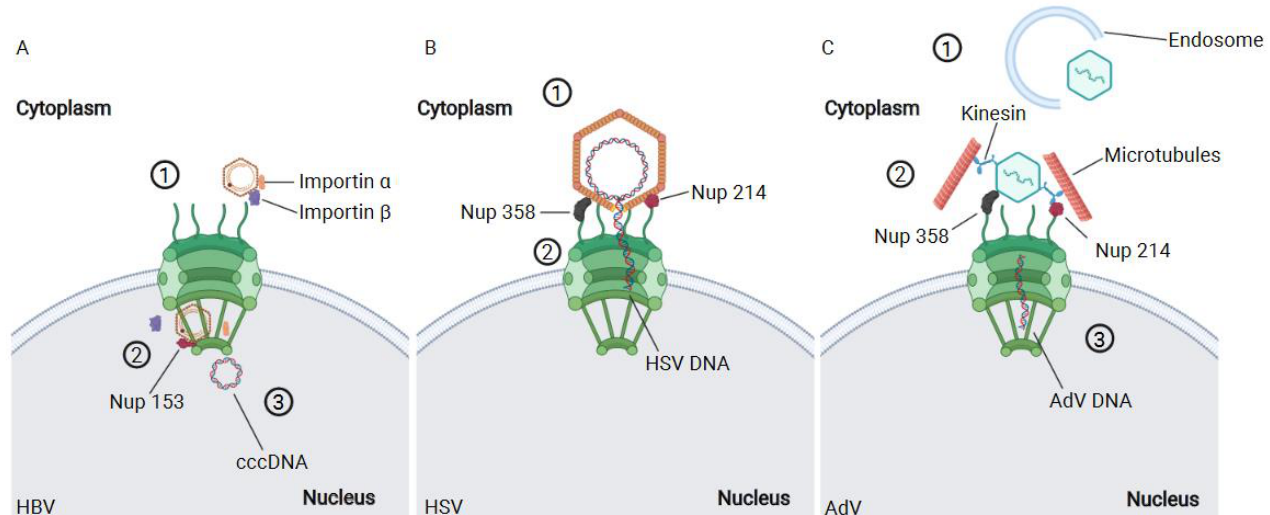
Figure 1. Different viruses employ various strategies in order to access to the nucleus. ( A ) The HBV travels to the vicinity of the NPC protected by its capsid. Thus, it employs importin α and β to access the nucleus (1). The small size of HBV capsid permits the import of this structure complete to the nucleus. The uncoating of HBV capsid takes place assisted by Nup 153 (2) releasing the genome in the nucleus of the cell (3). ( B ) The HSV capsid is too large to be imported complete to the nucleus. Therefore, the HSV binds to the cytoplasmic filaments of NPC via Nup358 and Nup214 (1). Once the capsid docks at the NPC, the viral DNA is injected to the nucleus (2). ( C ) The adenovirus uncoating begins during the release of the viral capsid from the endosomes (1) and is completed at the NPC (2), where there is a complex formed by the capsid, Nup 358, Nup214, microtubules, and kinesin. The mechanical stress caused by the binding to microtubules and to the NPC contributes to completing the tear down of adenovirus capsids. Eventually, the viral DNA is released in the nucleus (3). Created with BioRender.com accessed on 7 June 2021.